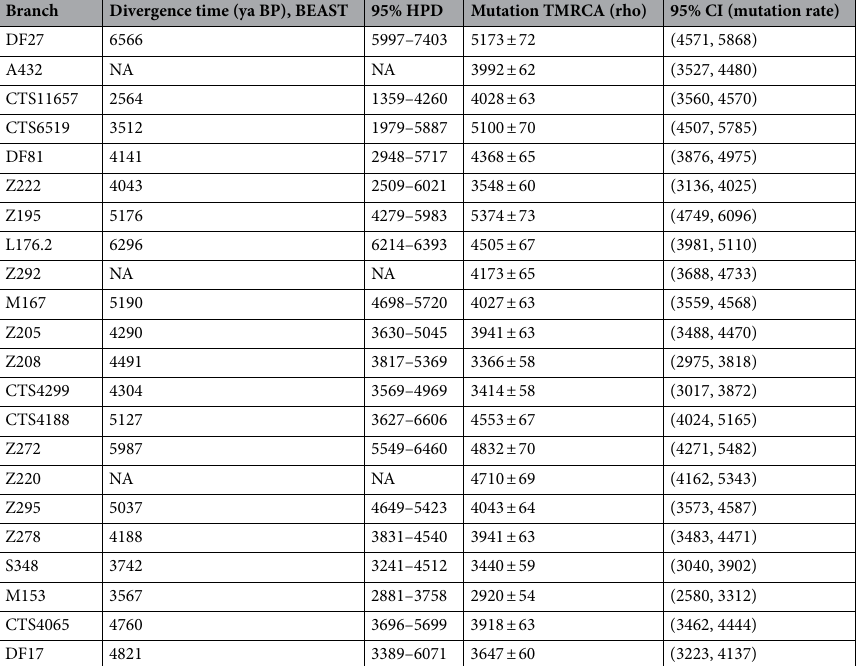
Table 1. Branch divergence times inferred with BEAST for DF27 and its sublineages, and 95% highest posterior density intervals. NA: branches that are not recovered as monophyletic in the BEAST tree (Supplementary Fig. 1). Rho TMRCA estimates (± standard deviation) and confidence intervals (computed from the 95% confidence interval for mutation rates).